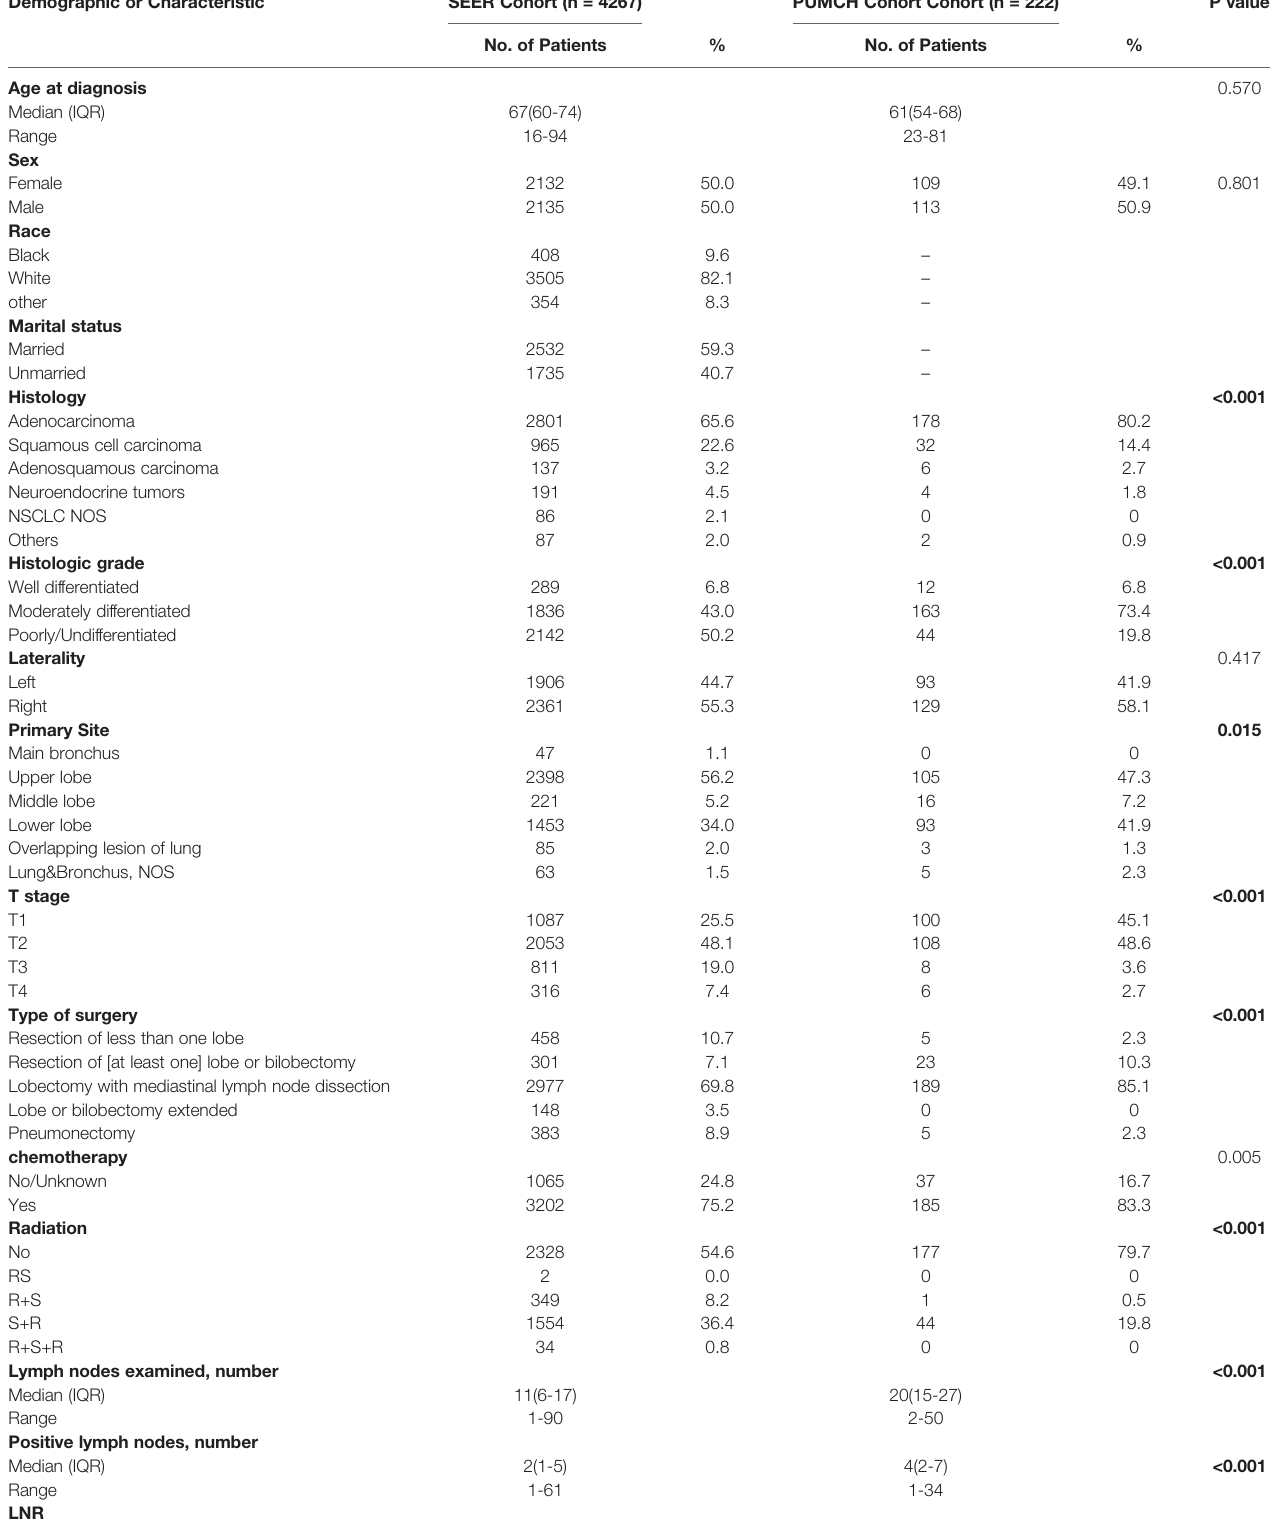
TABLE 1 | Demographics and Clinicopathologic Characteristics of Patients underwent surgery with pN2. Demographic or